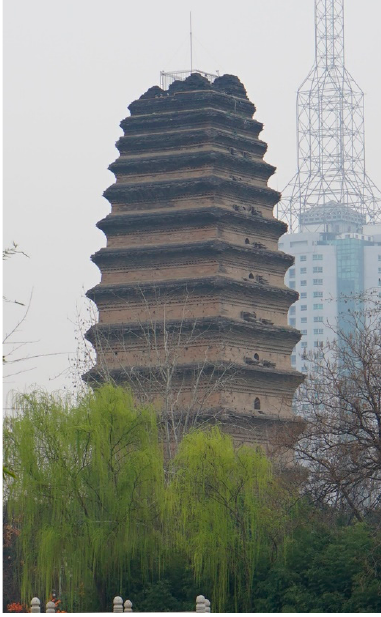
Figure 11. Xiaoyan ta Pagoda (provided by Yamaguchi Hiroyuki).